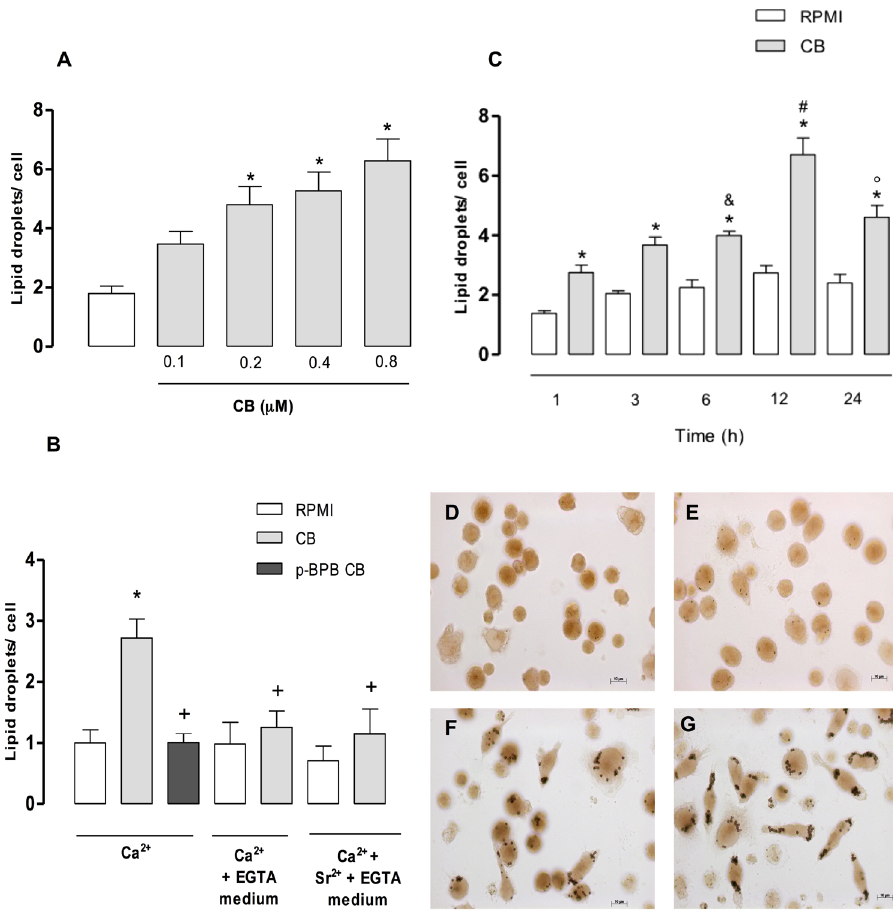
Figure 1. CB induces LD formation in peritoneal macrophages. ( A ) Effect of CB on LD formation in macrophages incubated with selected concentrations of CB or with RPMI (control) for 1 h. ( B ) Effect of catalytically active CB on LD formation in peritoneal macrophages incubated with one of the following for 1 h: (i) CB (0.4 μ M) in a medium containing EGTA (200 μ M) with or without Ca 2 + ; (ii) CB (0.4 μ M) in a medium in which Ca 2 + was replaced by Sr 2 + ; or (iii) RPMI alone (control) ( C ) Time-course of CB-induced LD formation. Macrophages were incubated with CB (0.4 µ M) or RPMI (control) for 1, 3, 6, 12 or 24 h. LDs were quantified using light microscopy after OsO 4 staining. ( D ) Osmium-stained LDs observed in control cells or in cells stimulated with CB (0.4 µ M) for 1 h ( E ), 6 h ( F ) or 12 h ( G ). Each bar represents the mean ± SEM of the number of LDs/cell in 50 cells. Values represent mean ± SEM for three to five animals. * p < 0.05 compared with RPMI-stimulated cells; & p < 0.05 compared with cells stimulated with CB for 1 h, # p < 0.05 compared with cells stimulated with CB for 1, 3 and 6 h, °p < 0.05 compared with cells stimulated with CB for 12 h, and + p < 0.05 compared with CB/Ca 2 + -stimulated